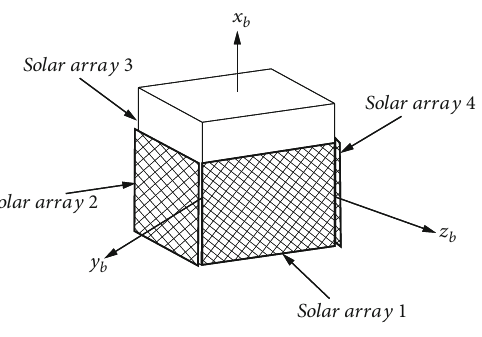
Figure 1: Diagram of the